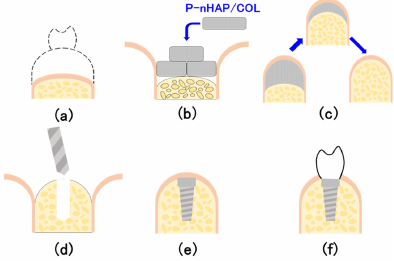
Figure 10. Schematic illustration of the future use of P-nHAP/COL: ( a ) bone-shallow area on mandible, ( b ) material application, ( c ) bone augmentation, ( d ) drilling and tapping for dental implant, ( e ) implant insertion, bone healing, and osteo-integration, and ( f ) screwing super-structure to dental implant. Supplementary Materials: The following supporting information can be downloaded at: www.mdpi.com/xxx/s1, Figure S1: Villanueva-stained histological images of the zone obtained from the rat cranial bone defect filled with one commercial alloplast (Bio-Oss) at 8 weeks after sur- gery at low magnification (a) and high magnification (b) with CL- fluorescent labeling (c); micro- CT sagittal section image (d).